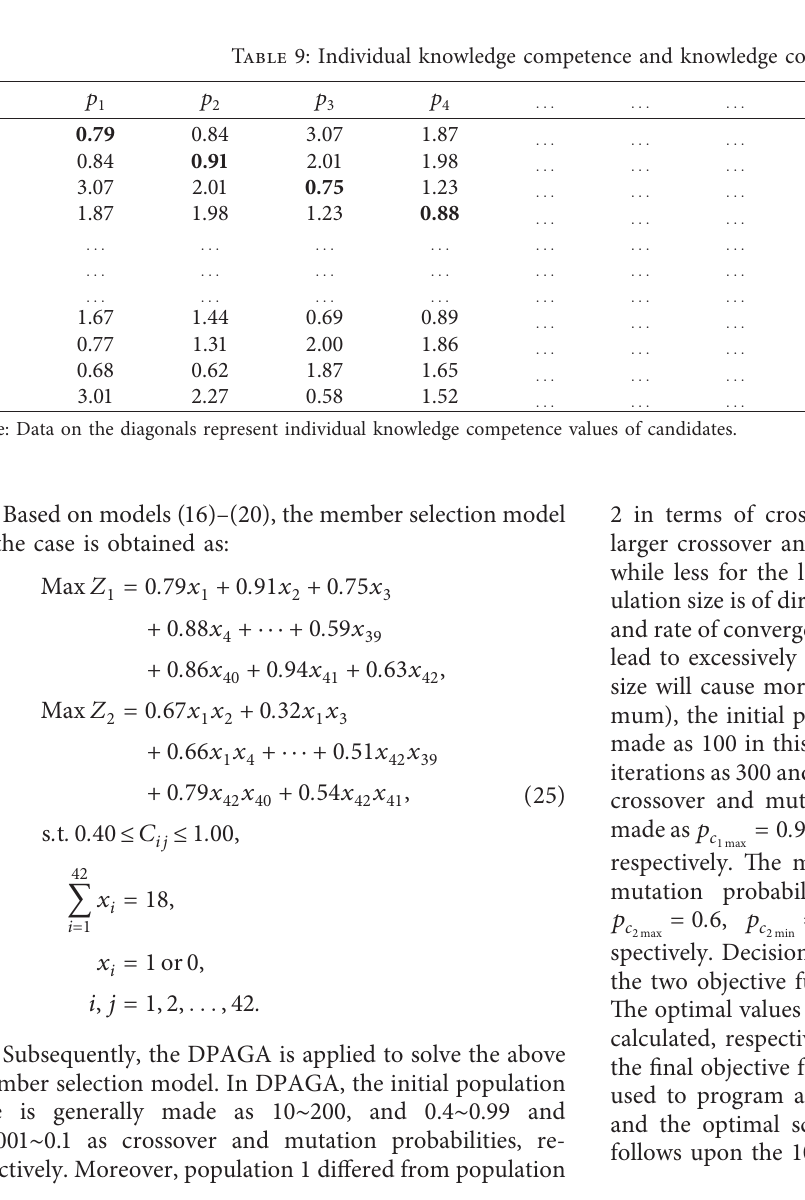
Table 8: Fuzzy information of expert evaluation under attribution S